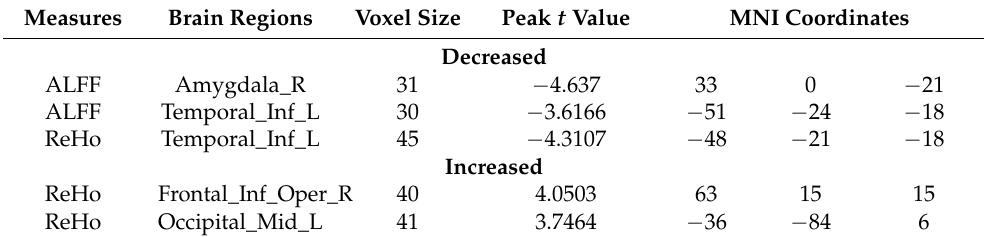
Table 4. Significant differences in ALFF and ReHo between MDDs and HCs.